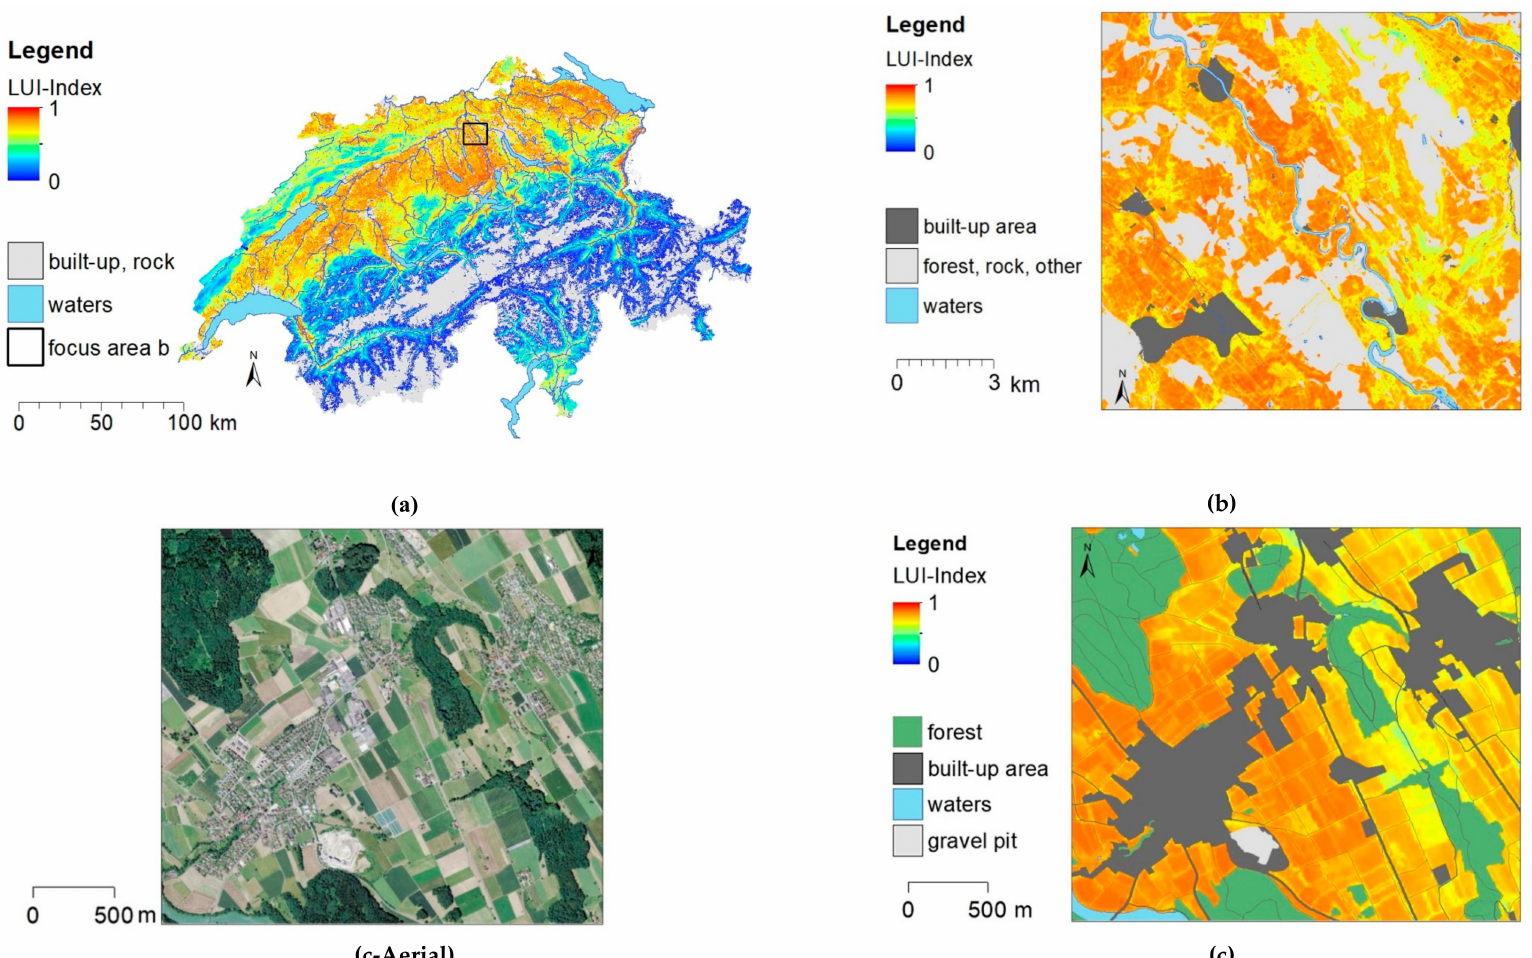
Figure 3. LUI map for the agricultural area based on the “full model” for the whole of Switzerland ( a ) and two zoom levels ( b , c ). ( c-Aerial ) is an aerial orthoimage of the same area. Settlements, forest, and areas without vegetation are masked in grey, and water bodies are masked in